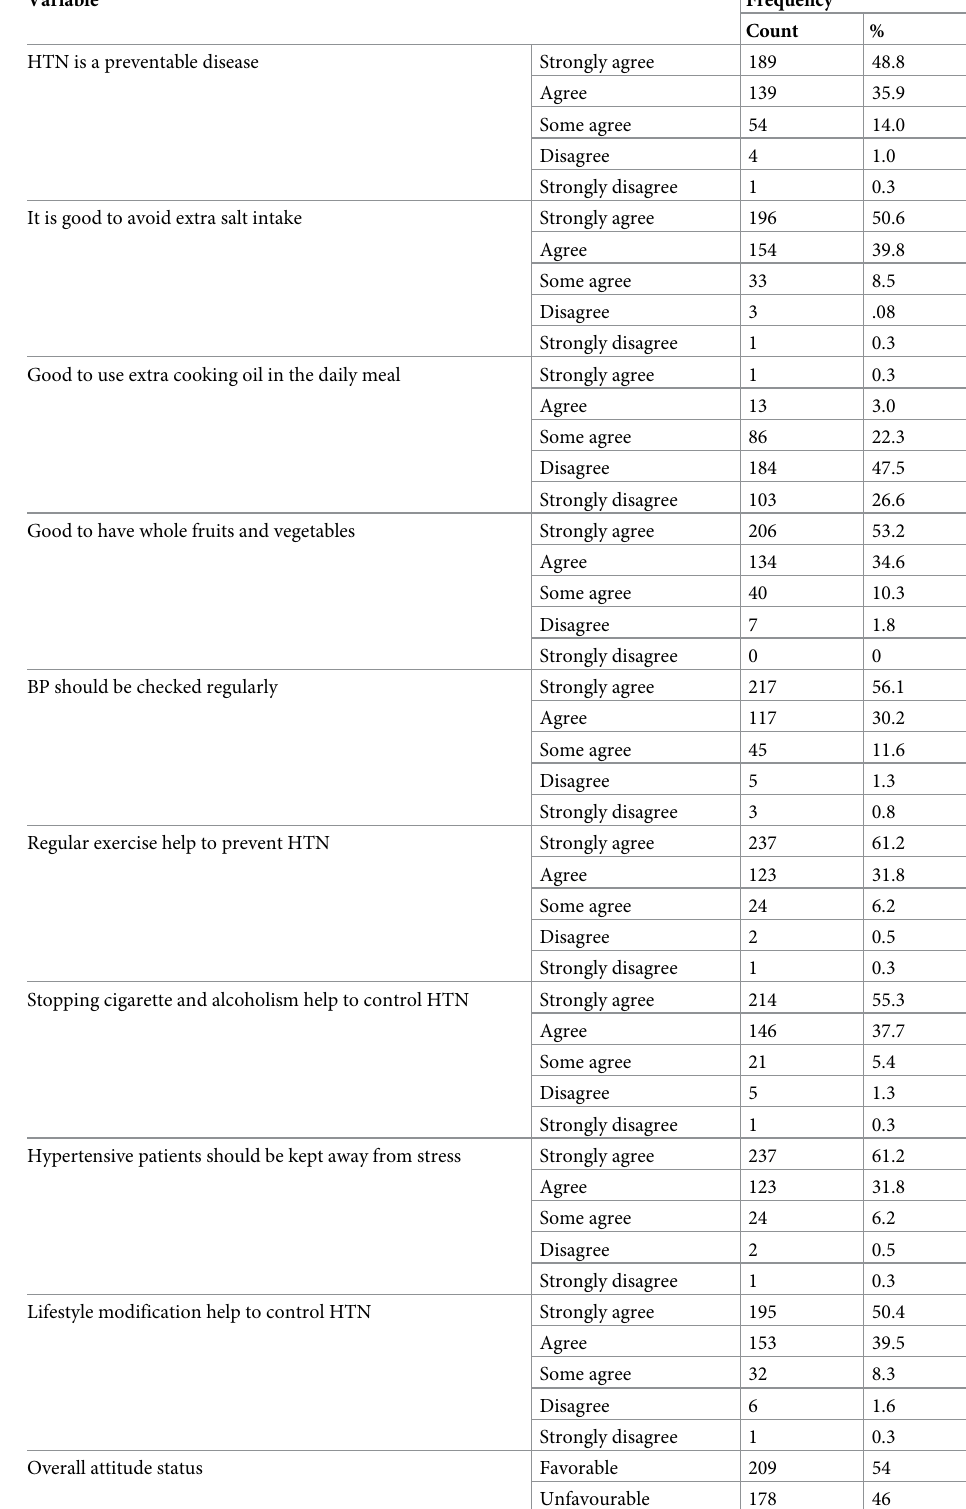
Table 5. Attitude of hypertensive patients on treatment follow up regarding lifestyle modification at Yekatit 12 General hospital in 2019 (n = 387).